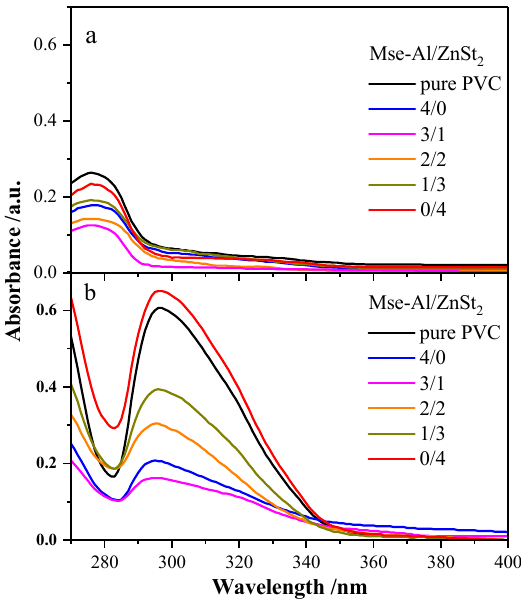
Figure 8. UV–Vis spectra of PVC samples stabilized with no stabilizer or with different mass ratios of thermal stabilizers heated for 0 min ( a ) and 90 min ( b ) at 180 °C.